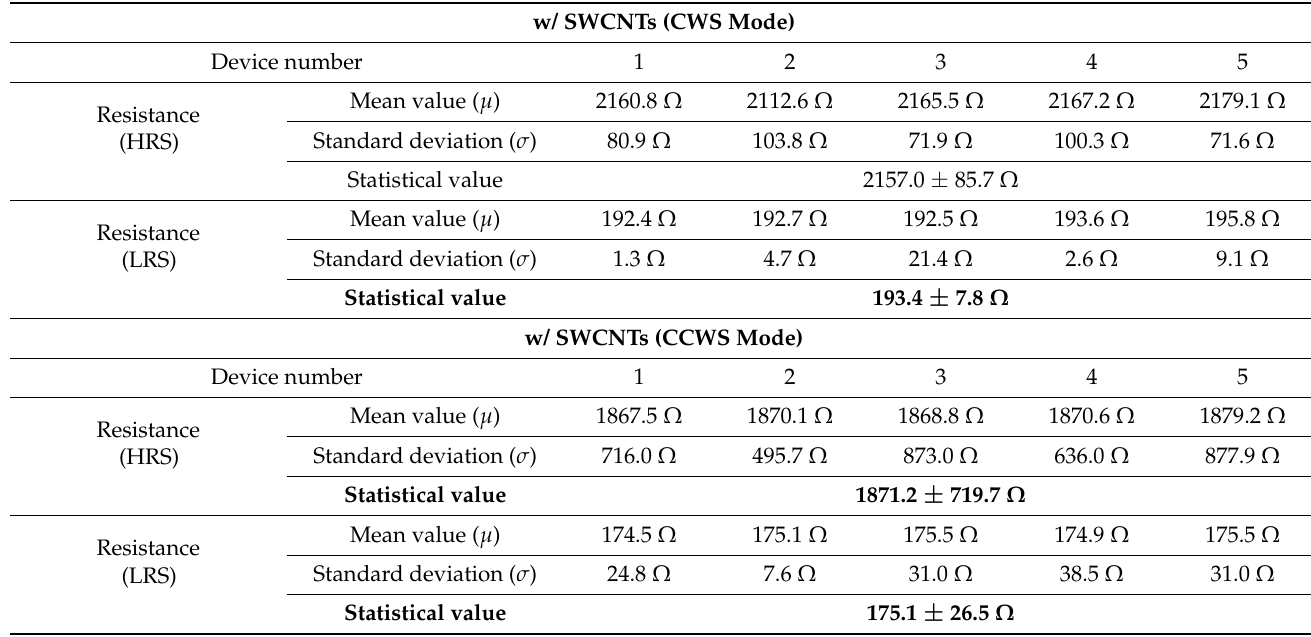
Table 2. Summary of the statistical resistance values in five HSQ memristors w/ the embedded SWCNT random network. w/ SWCNTs (CWS